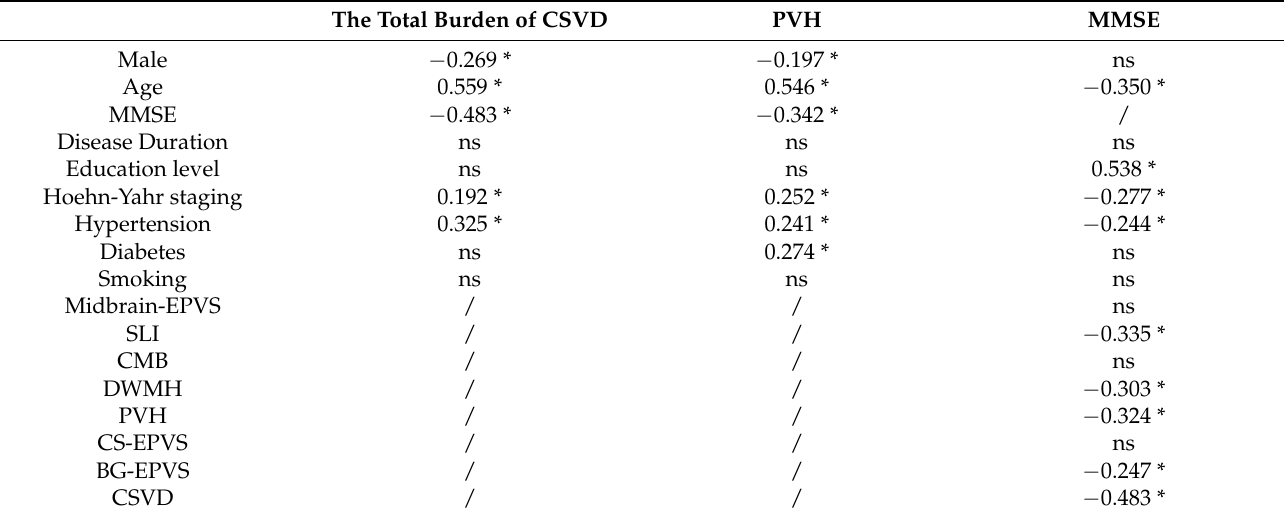
Table 2. Correlation analysis of the total burden of CSVD, PVH, MMSE and clinical